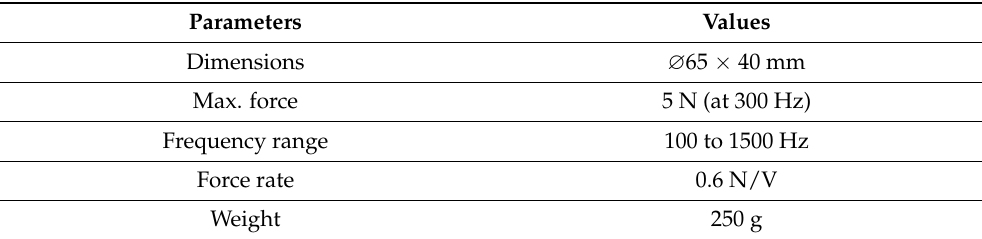
Table 1. Specifications of the